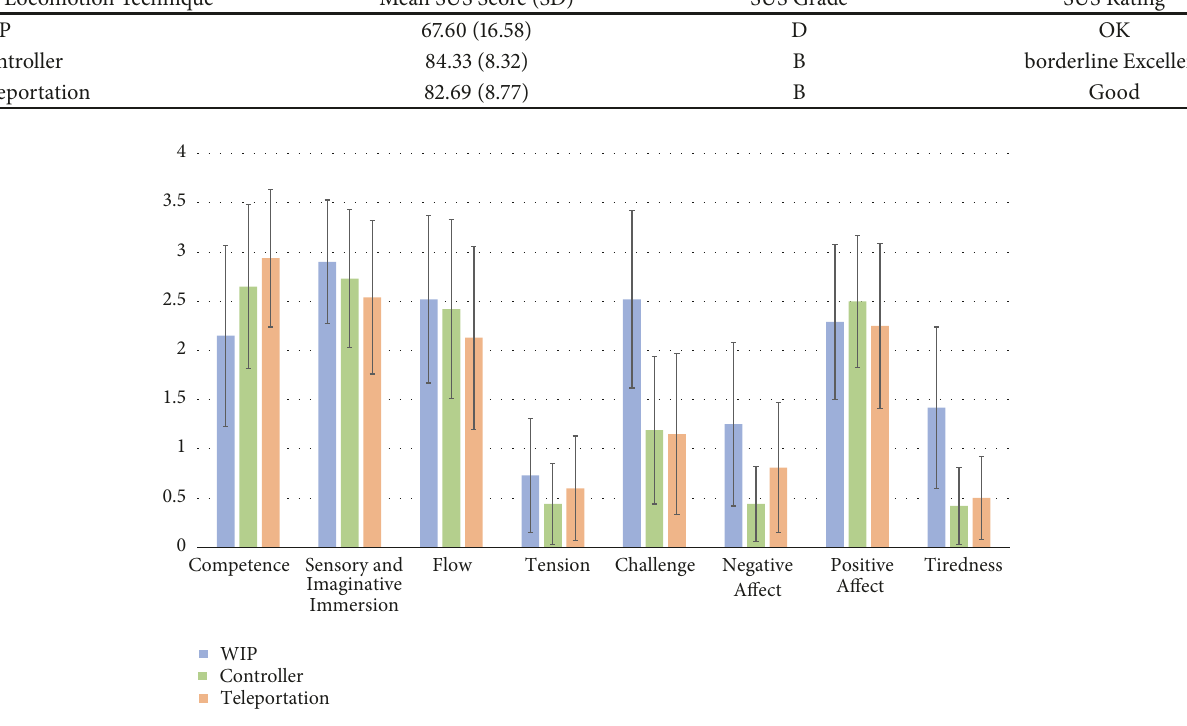
Figure 7: Mean GEQ values (with standard deviation bars) across eight experiential